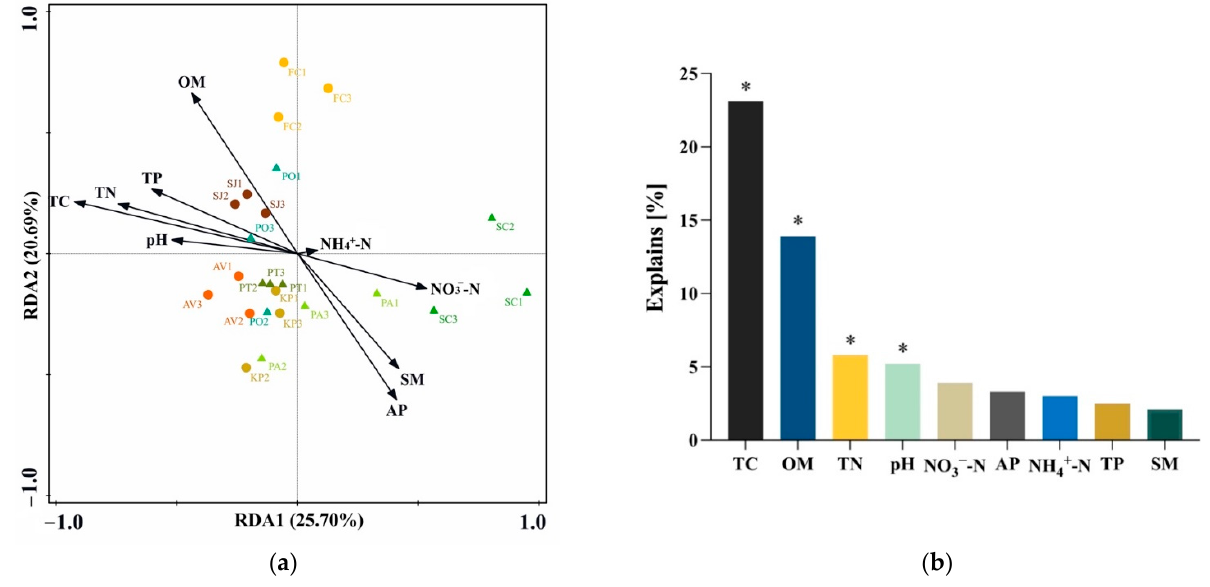
Figure 7. ( a ) Redundancy analyses (RDAs) between soil properties and rhizosphere bacterial community in different stands. ( b ) Explanation rate of soil properties to bacterial community variation.